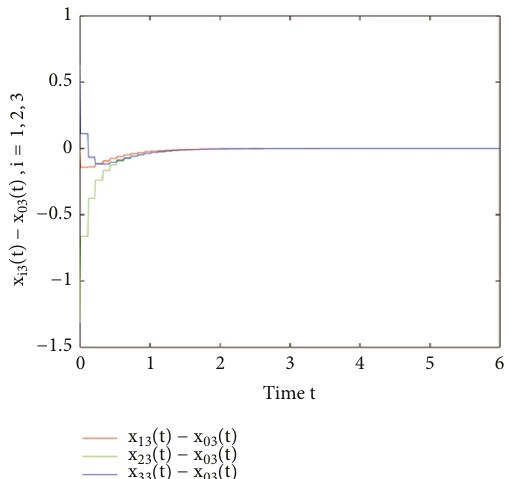
Figure 3: The 1 -dimensional errorvalueof agent 𝑥 𝑖 and leader agent 𝑥